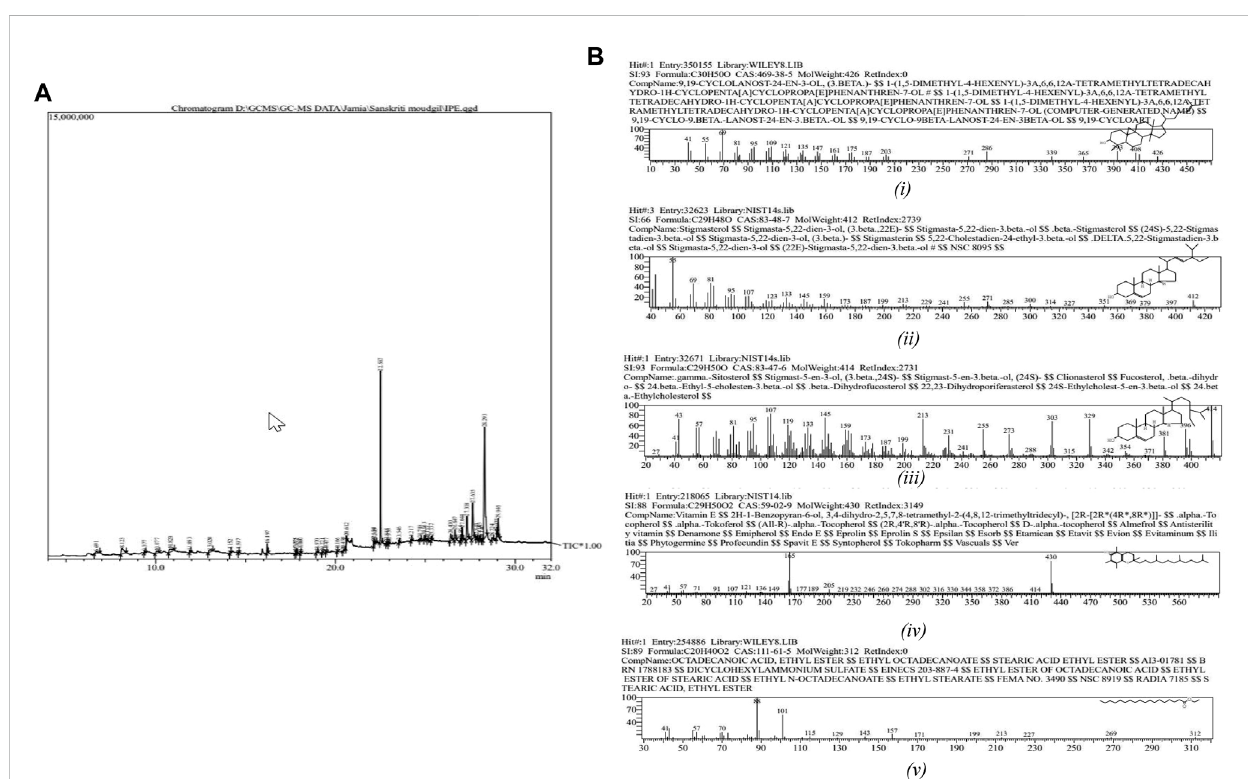
FIGURE 3 (A) Chromatogram of the GC-MS analysis of ethanolic root extract of Ipomoea turpethum. (B) Important compounds identi fi ed in the GC-MS analysis of the Ipomoea turpethum plant: i) 9,19-cyclolanost-24-en-3-ol, (3.beta.), ii) stigmasterol, iii) gamma-sitosterol, iv) vitamin E, and v) octadecanoic